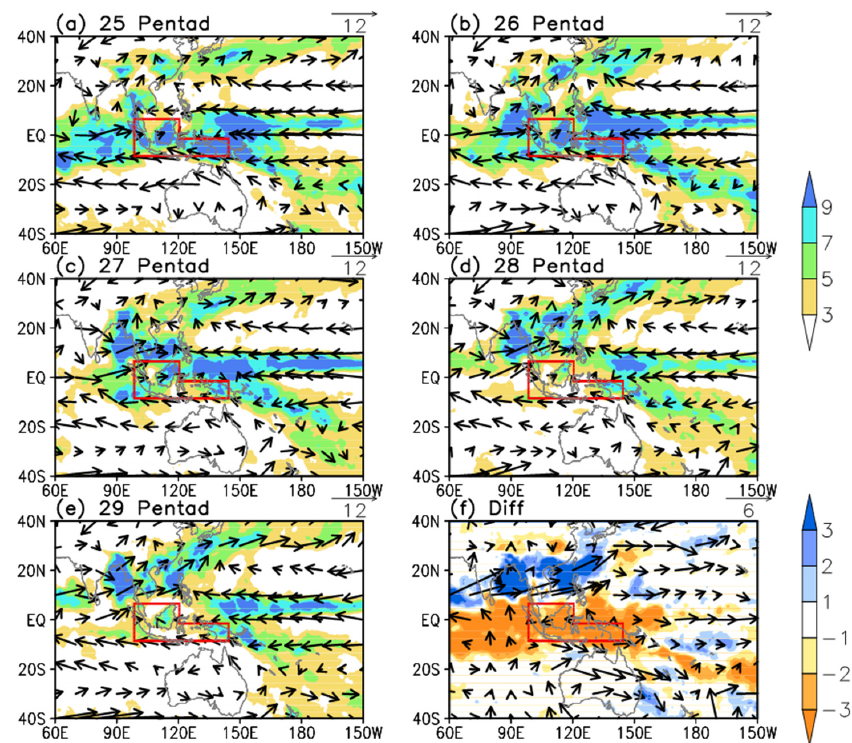
Figure 3. Climatological mean rainfall (GPCP; shading; mm/day) and 850-hPa winds (CFSR; vectors; m/s) for ( a ) 25th pentad; ( b ) 26th pentad; ( c ) 27th pentad; ( d ) 28th pentad; and ( e ) 29th pentad; ( f ) Differences between 28th–29th pentad mean and 25th–26th pentad mean. The domain of the Maritime Continent is outlined with red boxes.